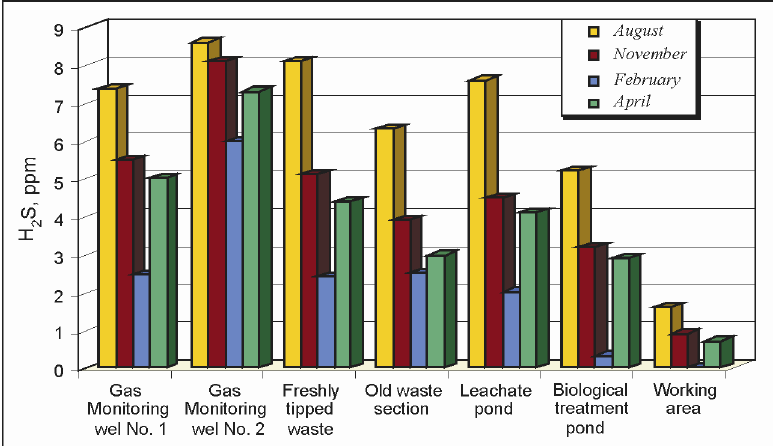
Fig. 3. H 2 S emissions (ppm) from different pollutant generation sources in the landfill